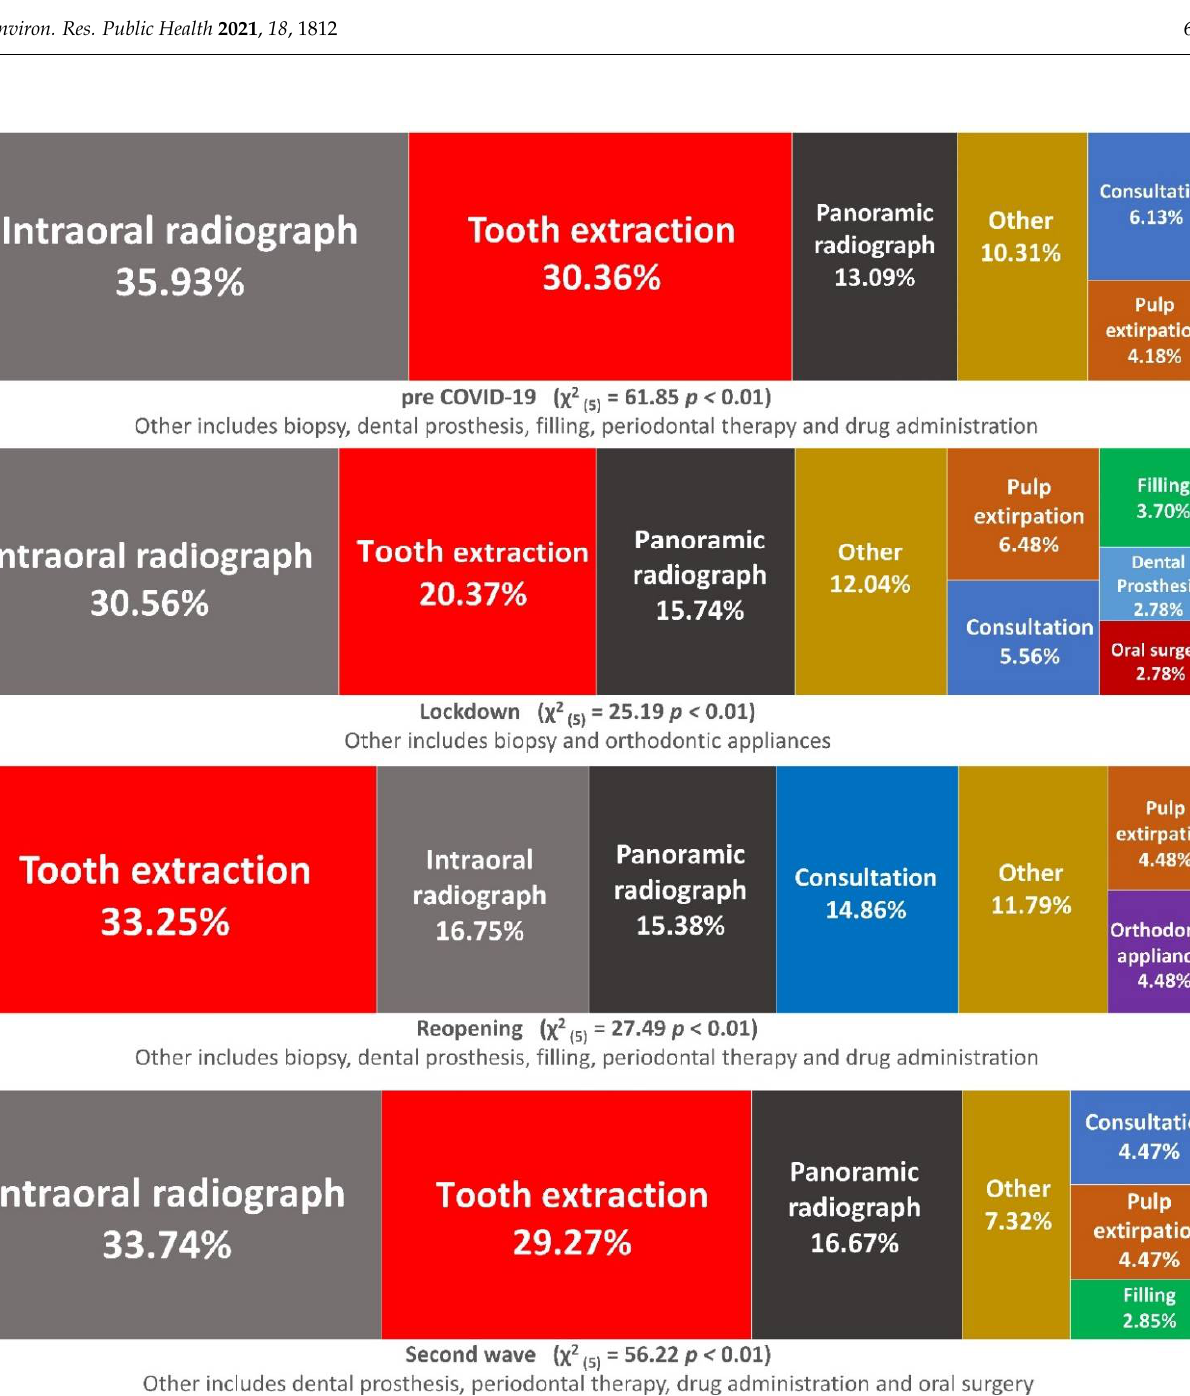
Figure 2. Prevalence of treatments and diagnostic exams performed in the different considered periods. Treatments that accounted for less than 2.5% each were grouped into the “Other” category.